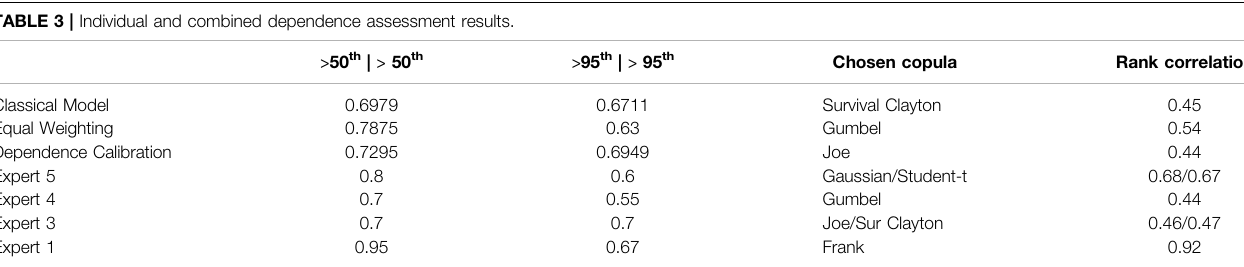
Frontiers in Applied Mathematics and Statistics |